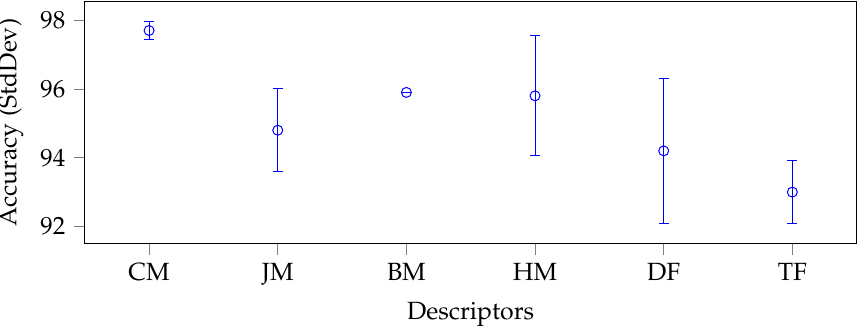
Figure 4. Average accuracy and standard deviation calculated on each descriptor category with the best classifier on average, for the Brain-Tumor-MRI data set.